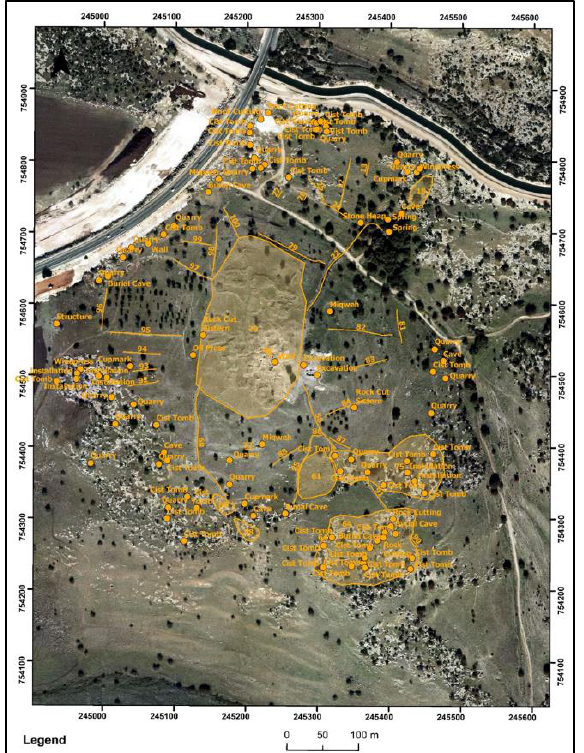
Figure 7. Archaeological survey as a basis for understanding the ancient landscape and site planning in Kh.